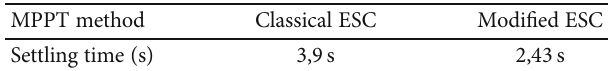
Figure 12: Root locus for the modi fi ed ESC algorithm. Table 2: 5% settling time